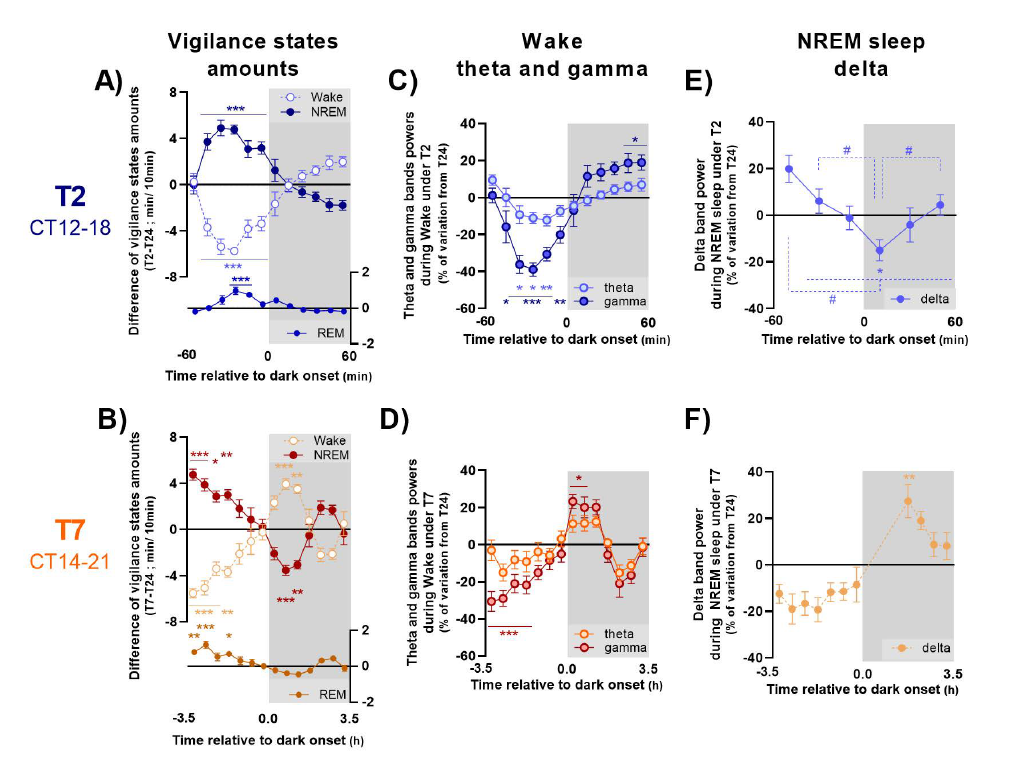
Figure 3. Time course of variation of sleep and waking amount and quality across light and dark exposures under T2 and T7 cycles compared to T24 cycle. Difference of wake (pale blue dotted lines), NREM (dark blue solid lines) and REM (pale blue solid lines) sleep amounts between T2 and T24 cycles per 10 min bins across light and dark exposures averaged for CT12-18 ( A ). Difference of wake (pale orange dotted lines), NREM (dark orange solid lines) and REM (pale orange solid lines) sleep amounts between T7 and T24 cycles per 30 min bins across light and dark exposures for CT14-21 ( B ). Difference of theta (pale blue lines) and gamma (dark blue lines) power during wake between T2 and T24 cycles per 10 min bins across light and dark exposures averaged for CT12-18 ( C ). Difference of theta (pale orange lines) and gamma (dark orange lines) power during wake between T7 and T24 cycles per 30 min bins across light and dark exposures for CT14-21 ( D ). Difference of delta power during NREM sleep between T2 and T24 cycles per 20 min bins across light and dark exposures averaged for CT12-18 ( E ). Difference of delta power during NREM sleep between T7 and T24 cycles per 30 min bins across light and dark exposures for CT14-21 ( F ). Circles represent means ± SEM. Grey areas delineate dark exposures. *, p < 0.05, **, p < 0.01, ***, p < 0.001: difference between results obtained under T2/T7 and T24 cycle for specific time; #, p < 0.05 at least: difference between time points for the percentage of variation of delta activity. T24: n = 10; T2: n = 9; T7: n =